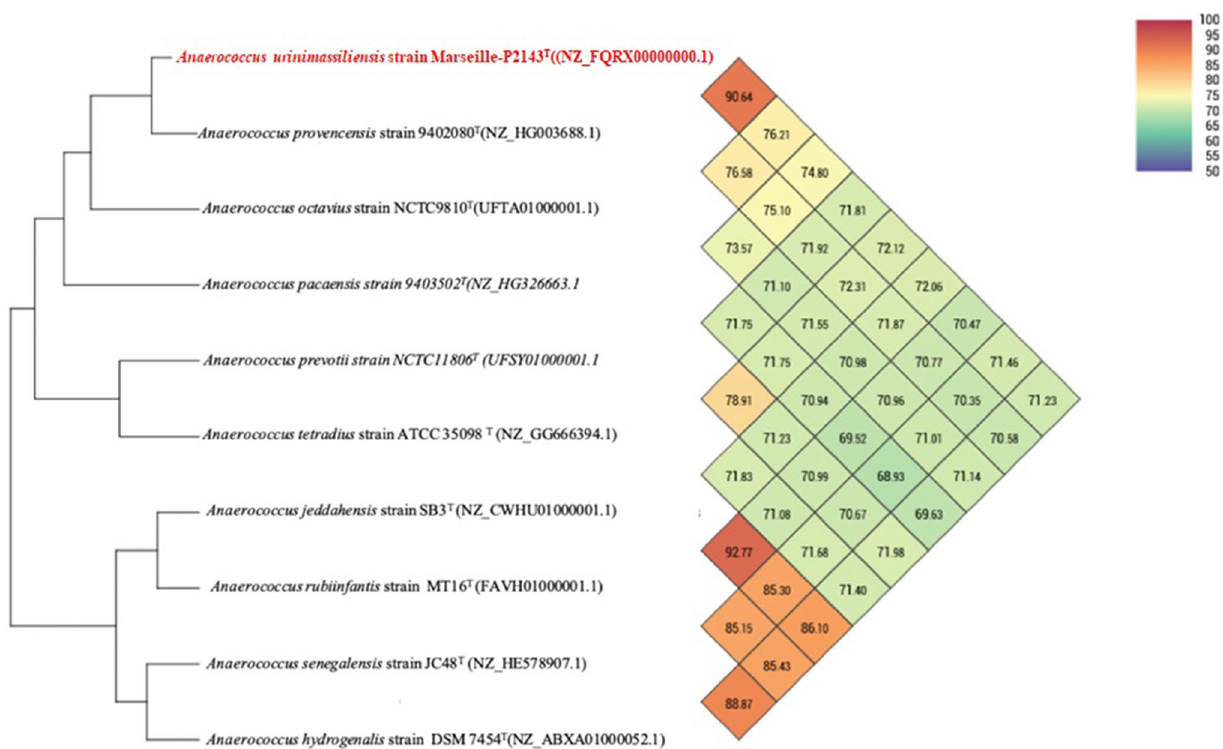
Figure 5. Heatmap generated with OrthoANI values calculated using the OAT software between Anaerococcus urinimassiliensis Marseille-P2143 T sp. nov. and other closely related species with standing in